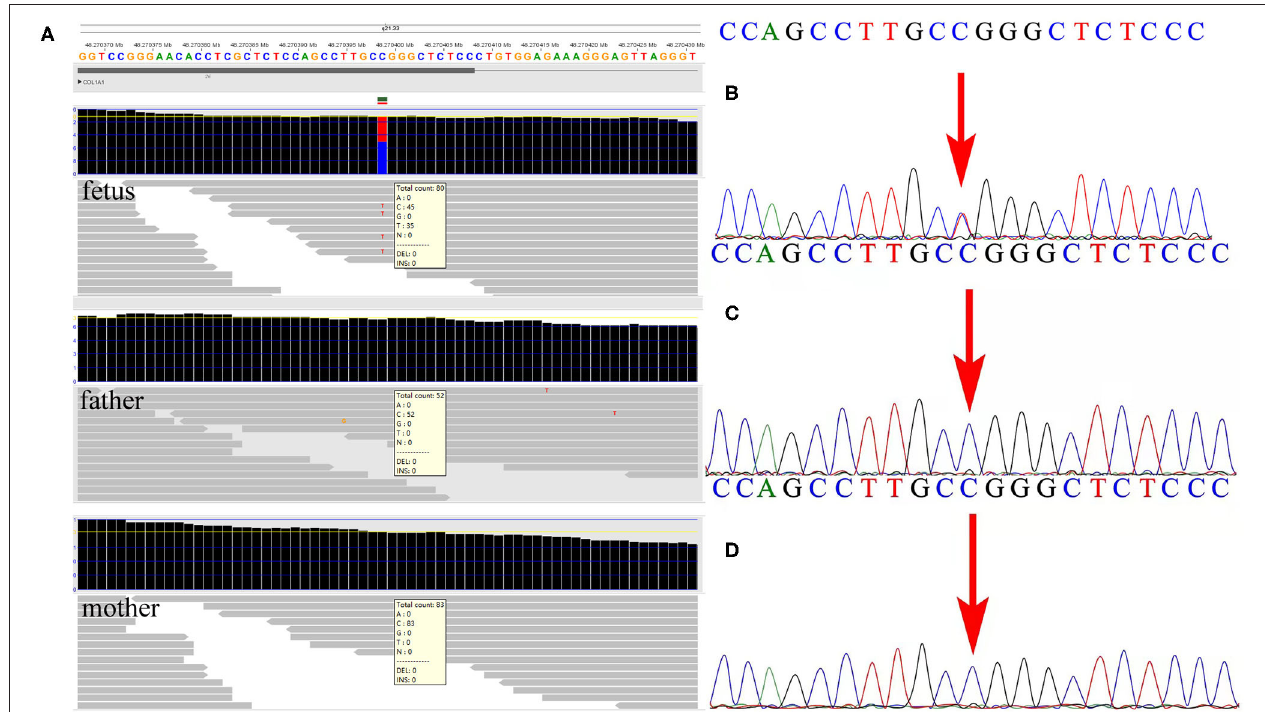
FIGURE 2 | Detection of the variant by whole-exome sequencing (WES) and verification by Sanger sequencing in the family. (A) The WES detection results demonstrated a de novo variant of c.1777G > A in exon 26 of the COL1A1 gene in the fetus. (B) Sanger sequencing verified the variant detected by WES in the fetus. (C,D) Neither parent carried the c.1777G > A mutation in the COL1A1 gene by Sanger